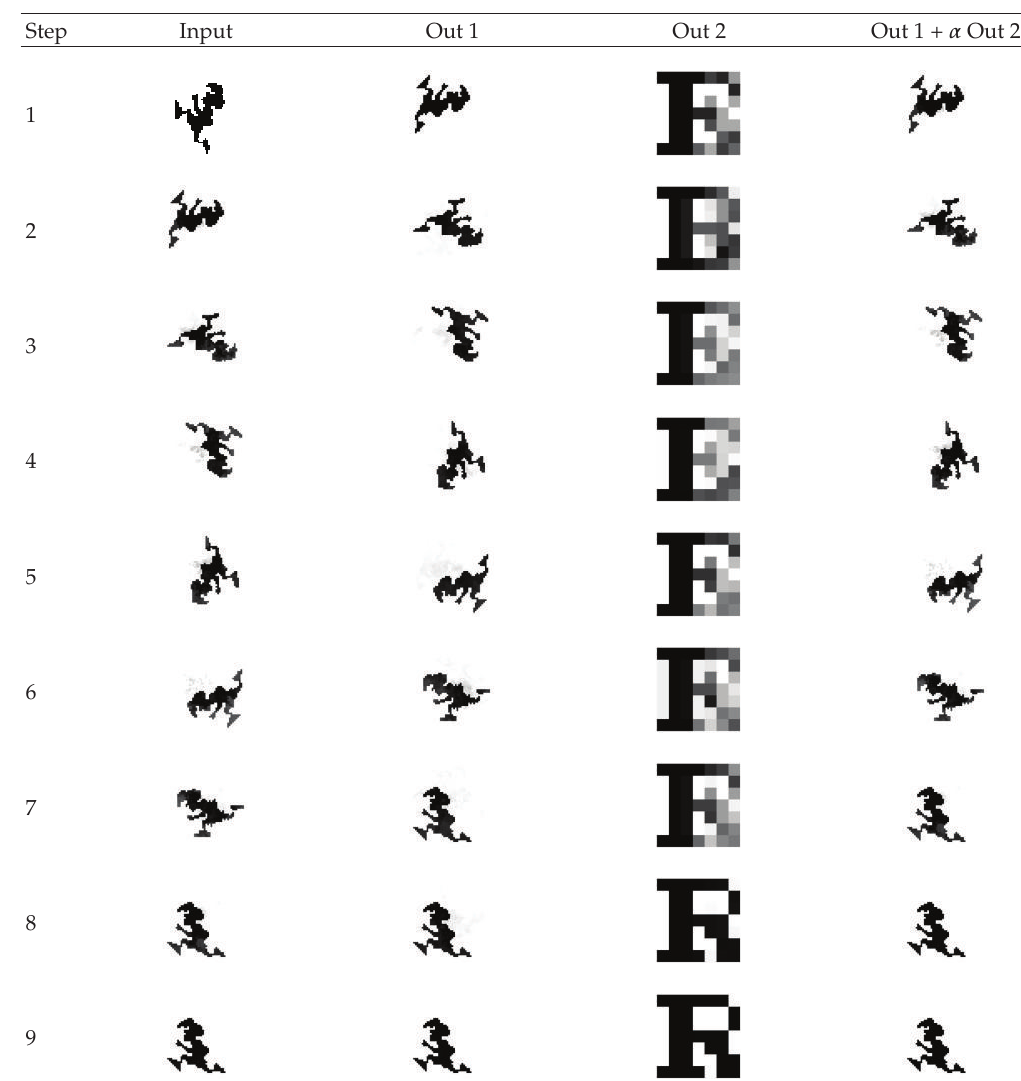
Table 15: Multistep recall of the “runner” binary picture (cid:3) 45 ◦ planar rotation (cid:4)